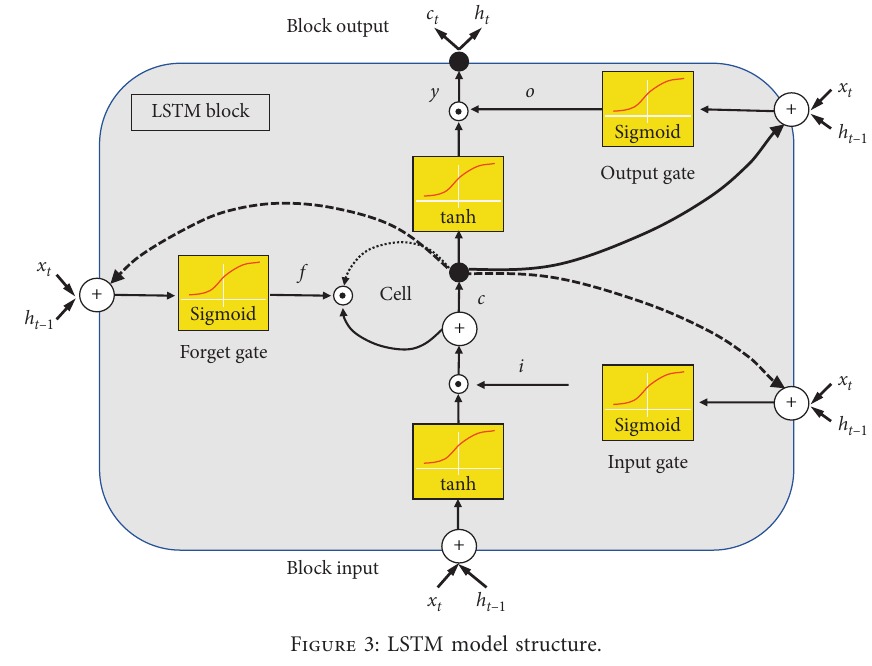
Figure 3: LSTM model structure.